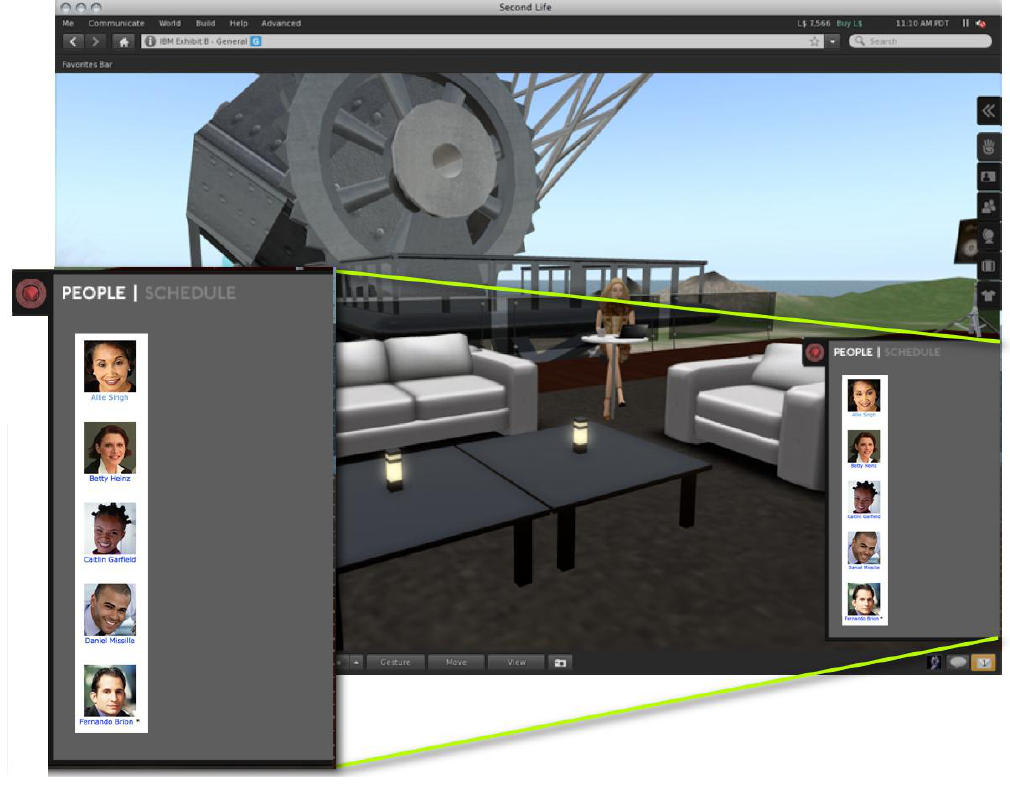
Figure 4. AGM 2009 Proposed Social Networking